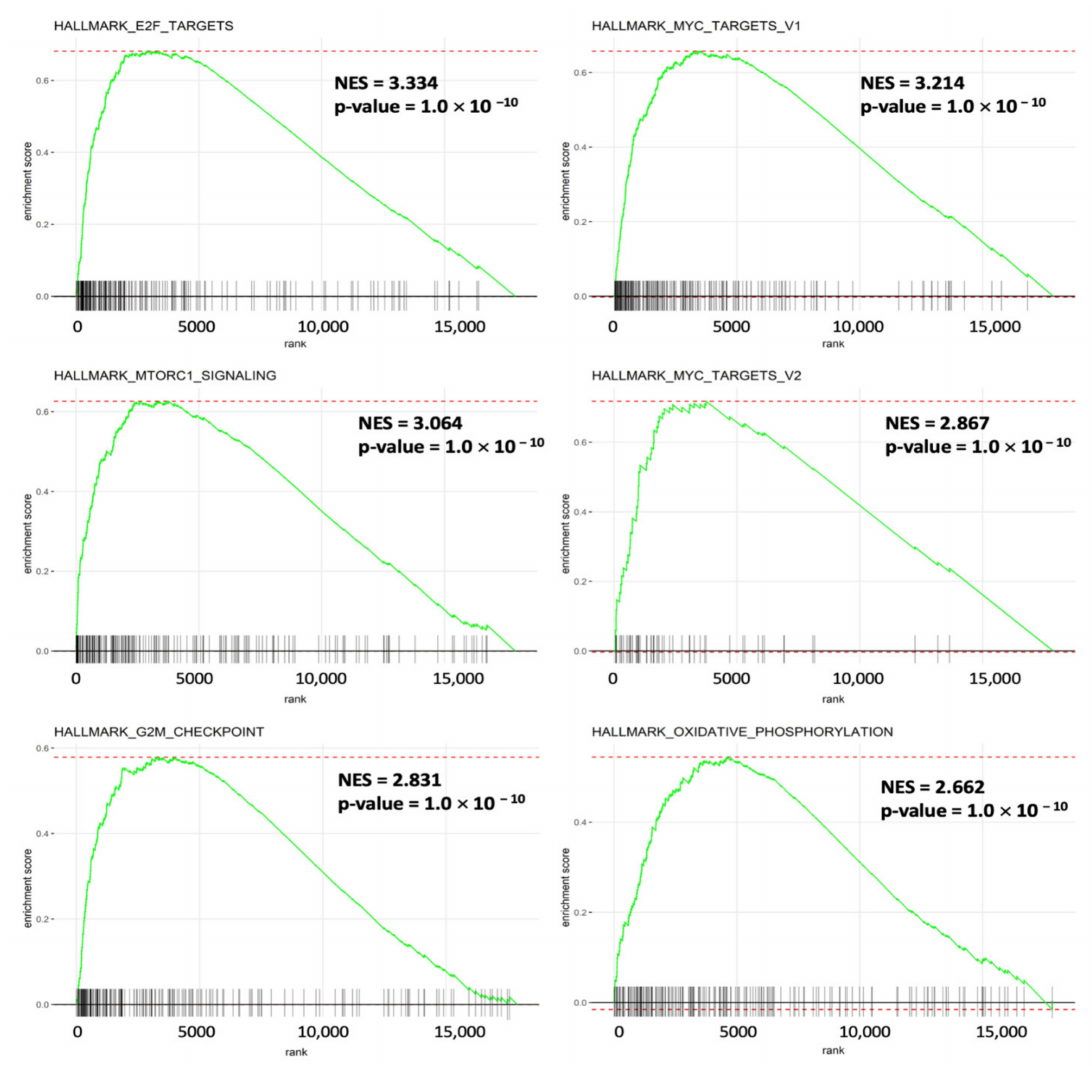
Figure 11. Results of a gene set enrichment analysis (GSEA) in breast cancer patients in TCGA cohort with high solute carrier 35A2 (SLC35A2) expression. Patients were divided into two halves depending on their SLC35A2 mRNA expression levels in the TCGA Pan-Cancer dataset; a corresponding ranking list of genes was then obtained and entered into the GSEA. Statistical significance was determined using a false detection rate (FDR) value of 0.25, a normalized enrichment score |NES| of >2, and a nominal p -value of 0.05, as recommended by the GSEA database. Enrichment at the top of the list is represented by a positive NES value, which depicts the enrichment pathway in the